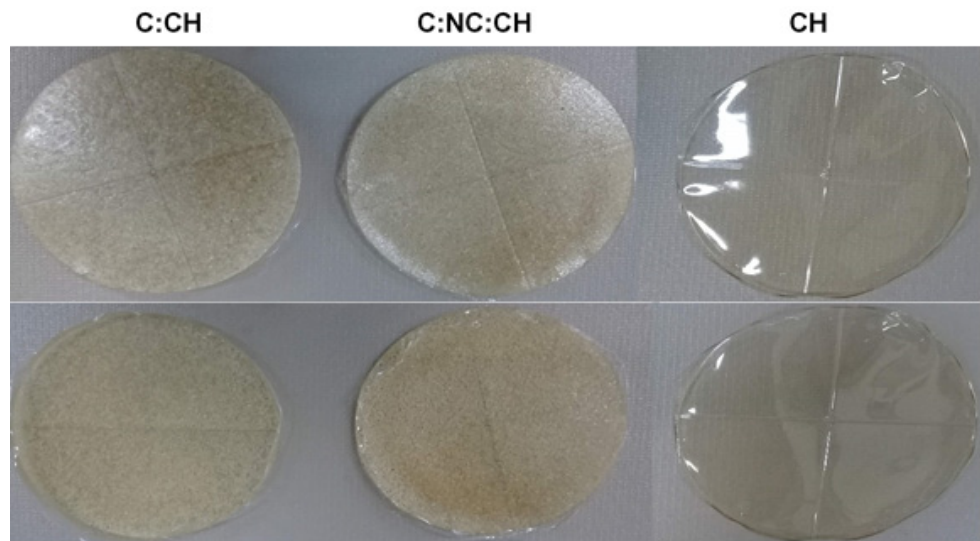
Figure 1. Appearance of edible films. C: Cellulose, NC: Cellulose Nanocrystals and CH: Chitosan.